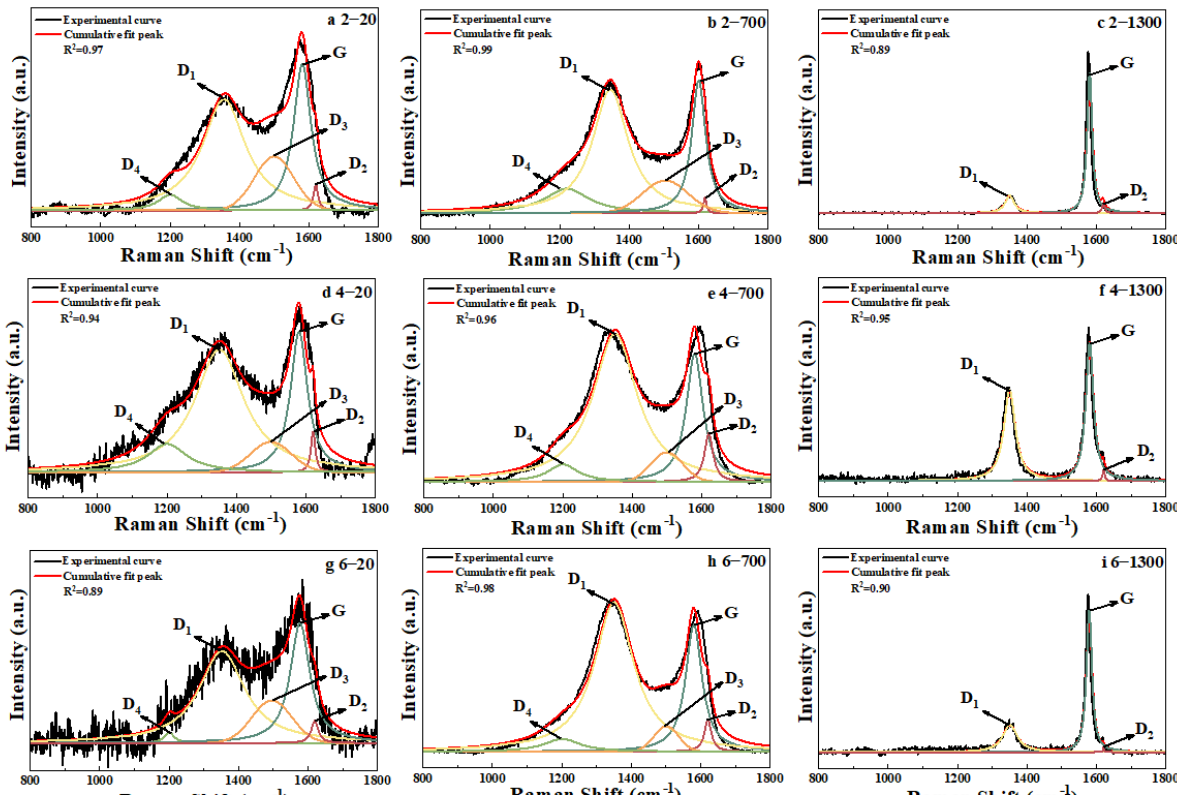
Figure 3. Assignments of curve-fitted bands for first-order Raman spectra in case of samples ( a ) 2-20, ( b ) 2-700, ( c ) 2-1300, ( d ) 4-20, ( e ) 4-700, ( f ) 4-1300, ( g ) 6-20, ( h ) 6-700, and ( i ) 6-1300.